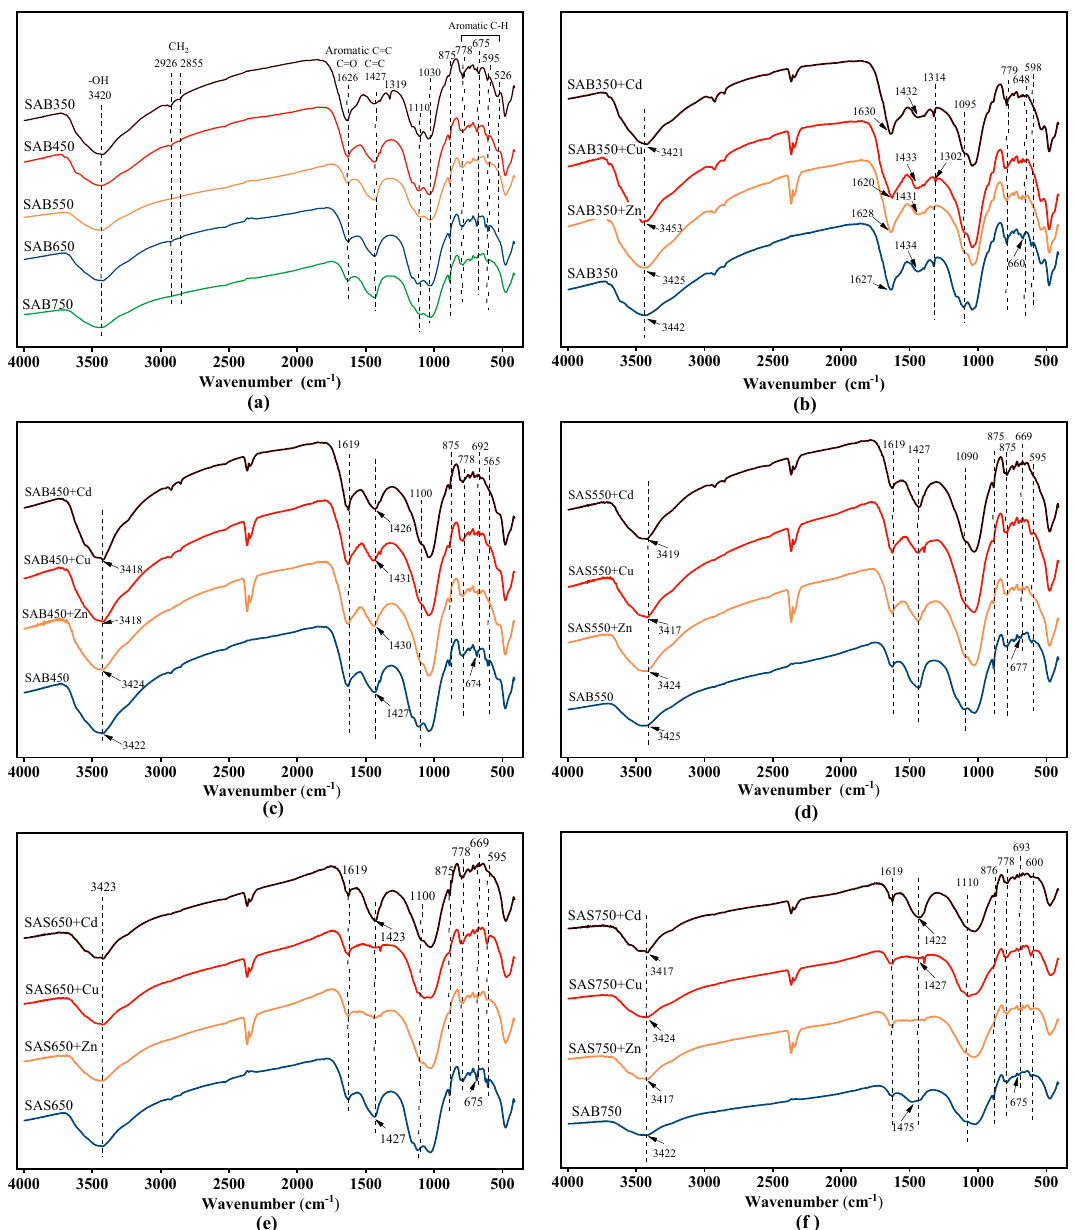
Figure 8. ( a ) Fourier transform infrared spectra (FTIR) spectra of biochar at 350–750 °C pyrolysis temperature. FTIR spectra of SAS350 ( b ), SAS450 ( c ), SAS550 ( d ), SAS650 ( e ), and SAS750 ( f ) before and after sorption.